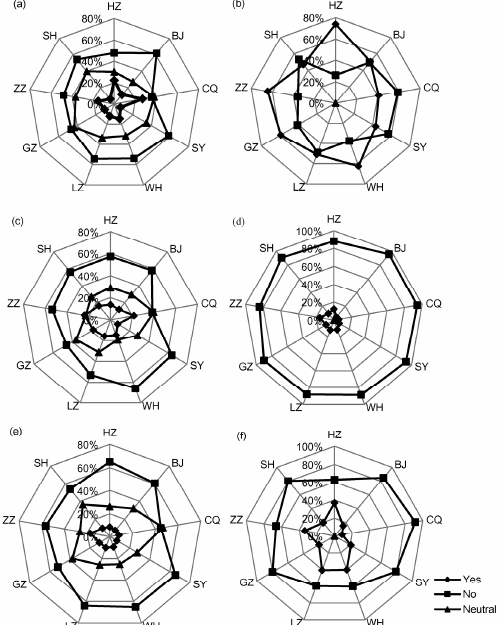
Table 4. Residents’ perception on execution capability of local